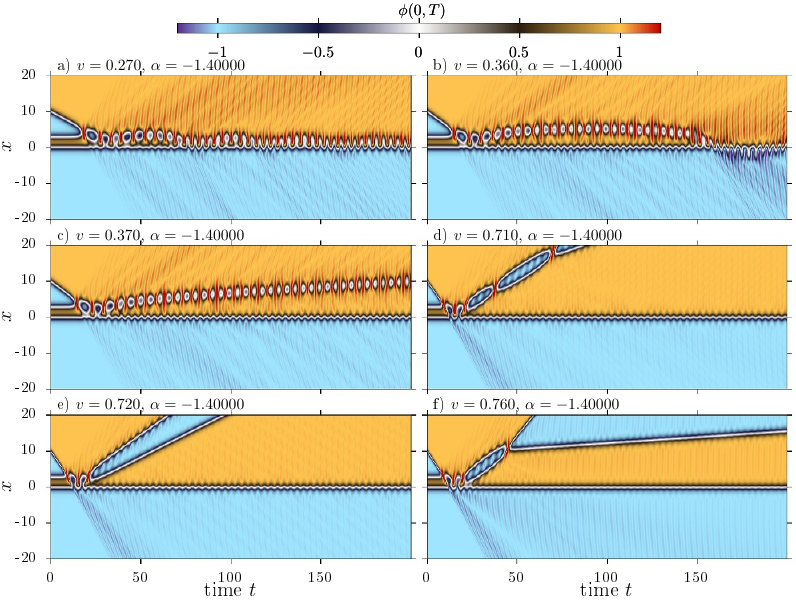
Figure 21 . Chaotic behaviour of the oscillon after the kink-impurity ((cid:6) (cid:0) + K ) collisions for (cid:11) = (cid:0) 1 : 4. The velocity values are a) v = 0 : 27, b) v = 0 : 36, c) v = 0 : 37, d) v = 0 : 71, e) v = 0 : 72 and f) v = 0 :